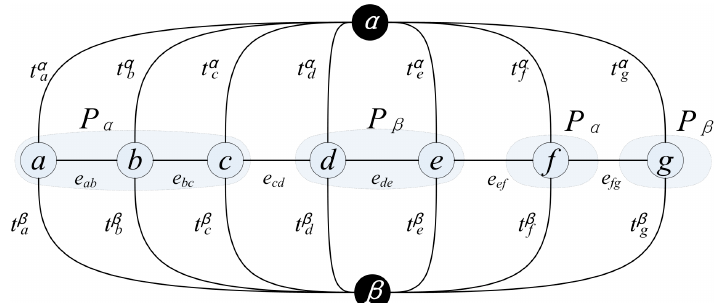
Figure 4 . The α - β graph. Figure 4. The α - β